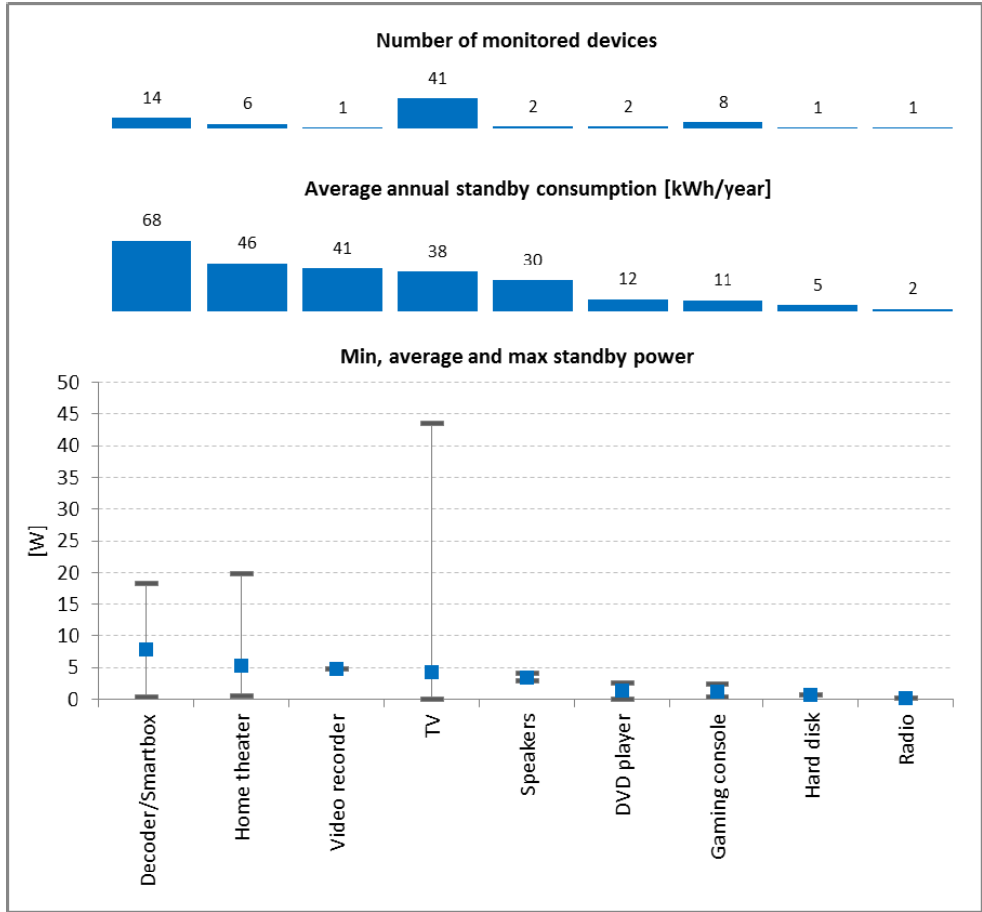
Figure 2. Average standby consumption (kWh/year). Minimum, average, and maximum standby power demand for different classes of devices (television (TV) and peripherals).